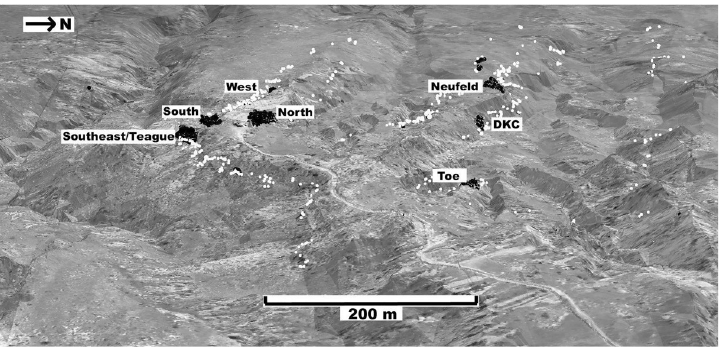
Fig 4. Three-dimensional aerial view of the hanson ranch field area including main and exploratory quarries discusses in the text. White dots indicate location of individual bones, outlining the bonebed layer through the hills between formal excavation sites. The black dots indicate where bones were collected in the